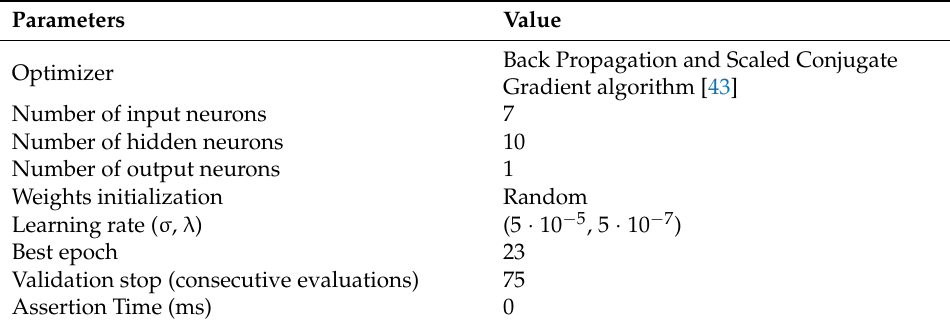
Table 3. MLP-NN training